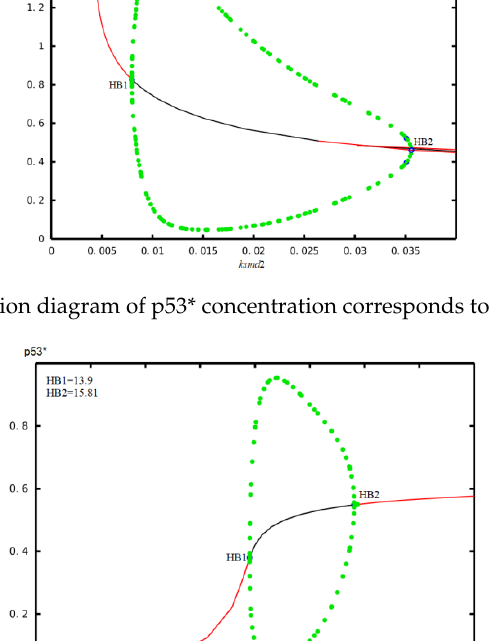
Figure 9. The bifurcation diagram of p53* concentration corresponds to the parameter k fp .